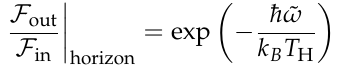
Figure 12. QNMs with and (cid:96) = m =